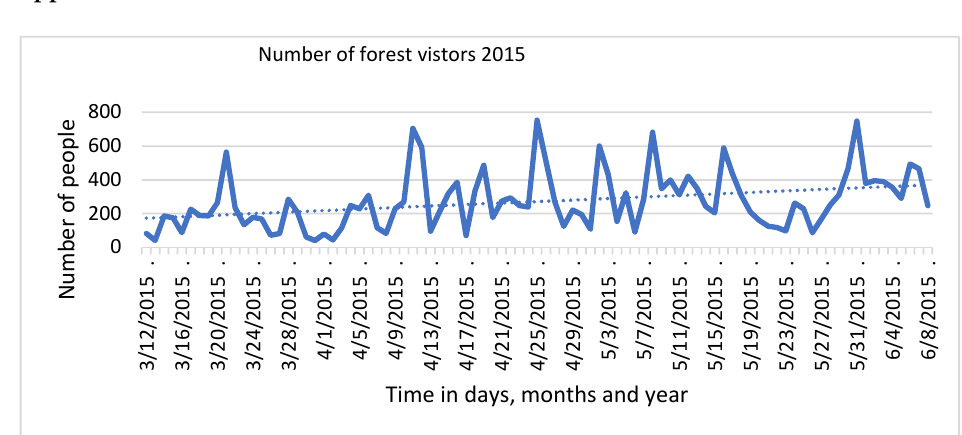
Figure A1. Recorded number of visitors per day in three months in 2015.